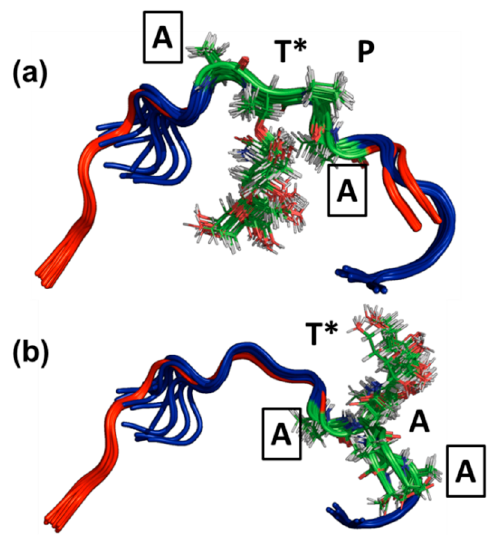
Figure 5. Similarity between the two AFGP8 proteins and motif definitions. ( a ) Local structural